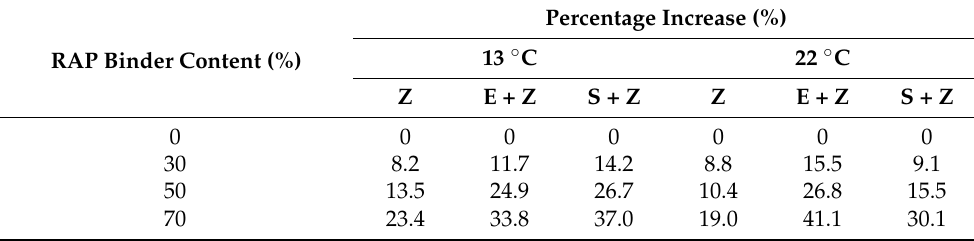
Table 9. Percentage increase in | G *| · sin δ with the RAP binder content under the long-term aged condition.